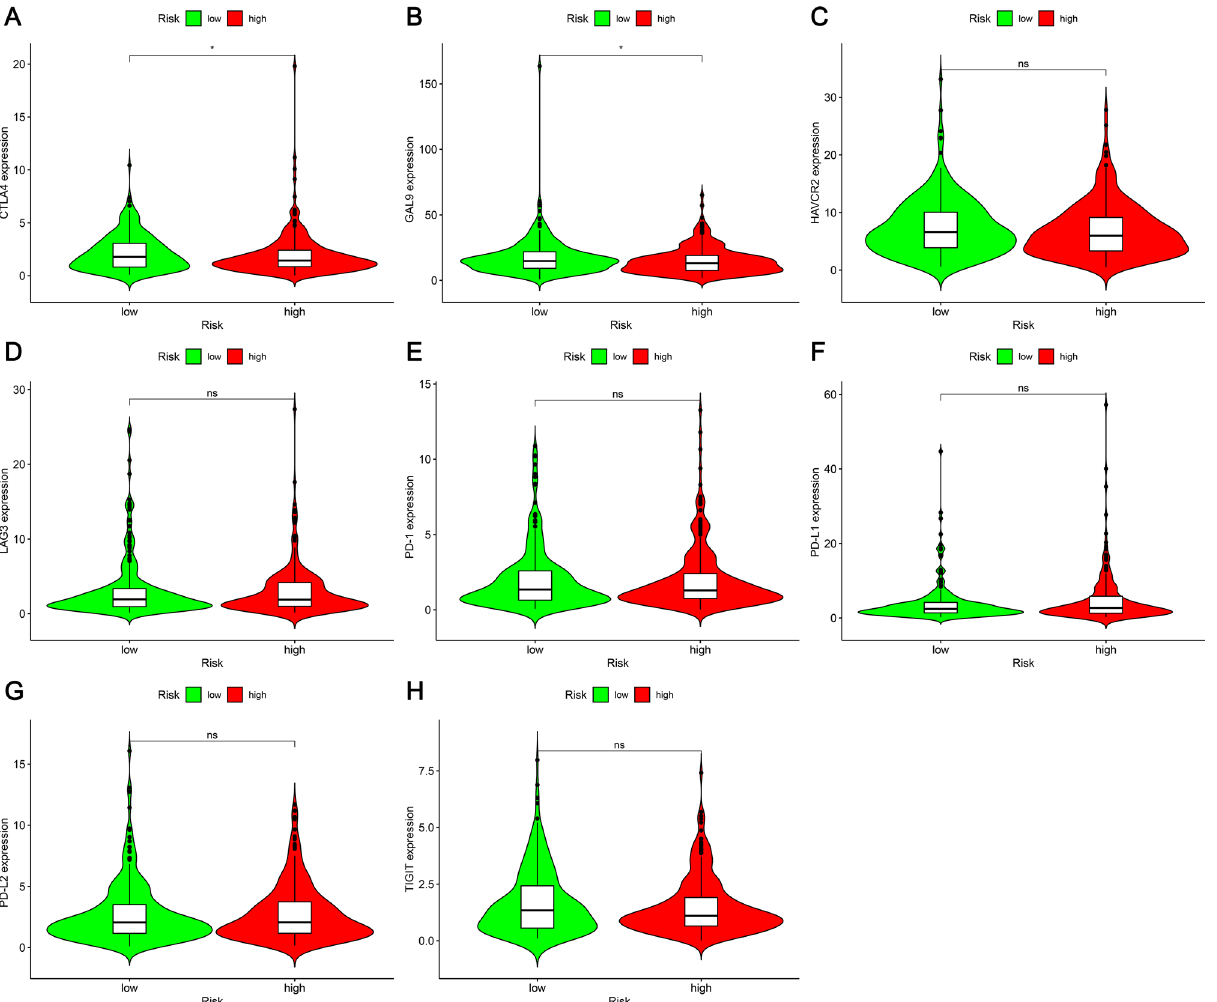
Figure 8. The link between ICI-related genes and risk model in LUAD. The levels of expression of ( A ) CTLA4; ( B ) GAL9; ( C ) HAVCR2; ( D ) LAG3; ( E ) PD1; ( F ) PD-L1; ( G ) PD-L2; ( H ) TIGIT in high-risk and low-risk groups. Ns not significant; *p <